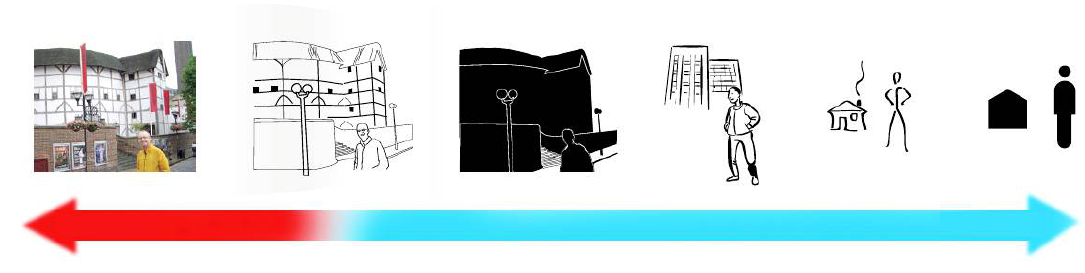
Figure 7. Realism continuum may show an array of pictures of different fidelity which bear a relationship to the same image. Pictures may range from ‘Concrete to Abstract’, ‘Specific to Universal’, from ‘Identification to Categorization’ among other visual communication